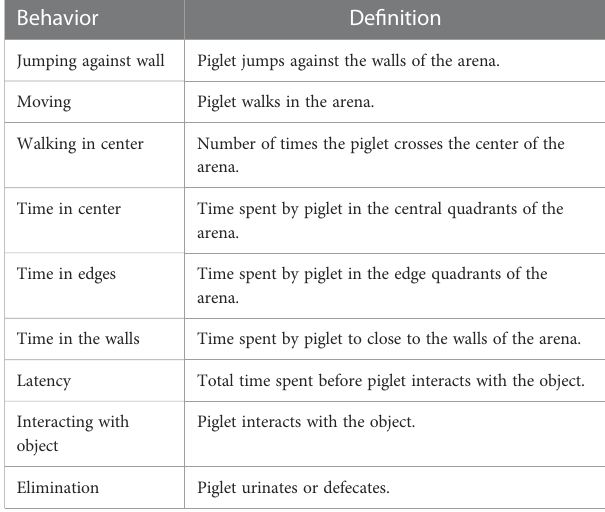
TABLE 2 De fi nitions of behaviors assessed in the Open fi eld and Novel object tests. Behavior De fi